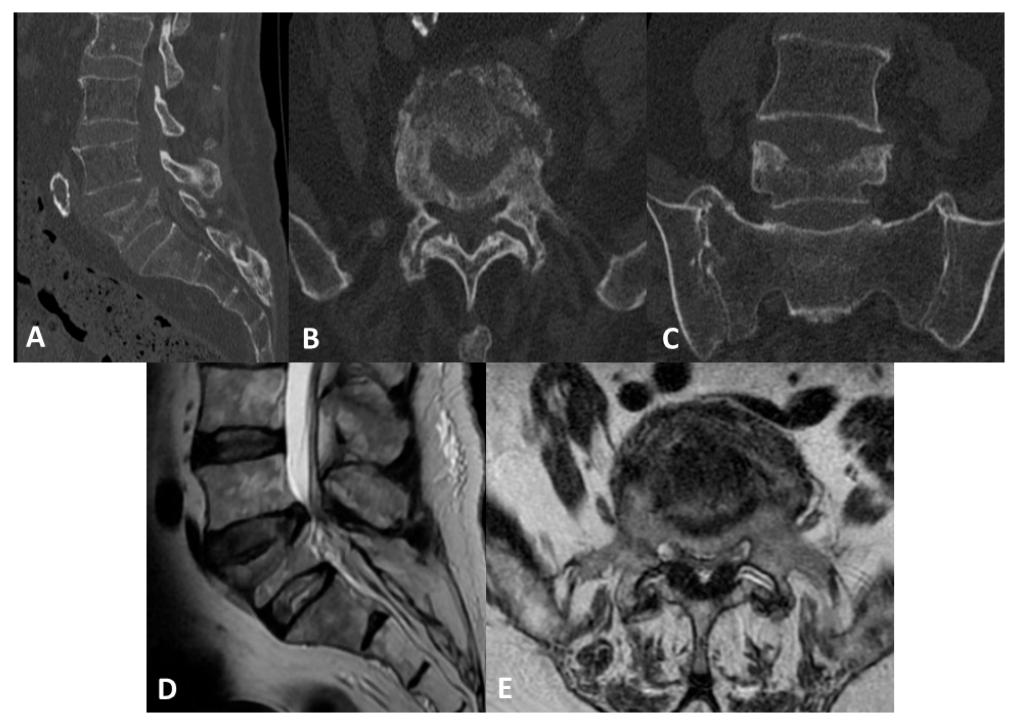
Figure 1. ( A ) Sagittal CT scan of the L5 fracture; ( B ) axial CT scan at the fracture level; ( C ) coronal CT scan; ( D ) sagittal MRI scan of the L5 fracture; ( E ) axial MRI scan at the fracture level.